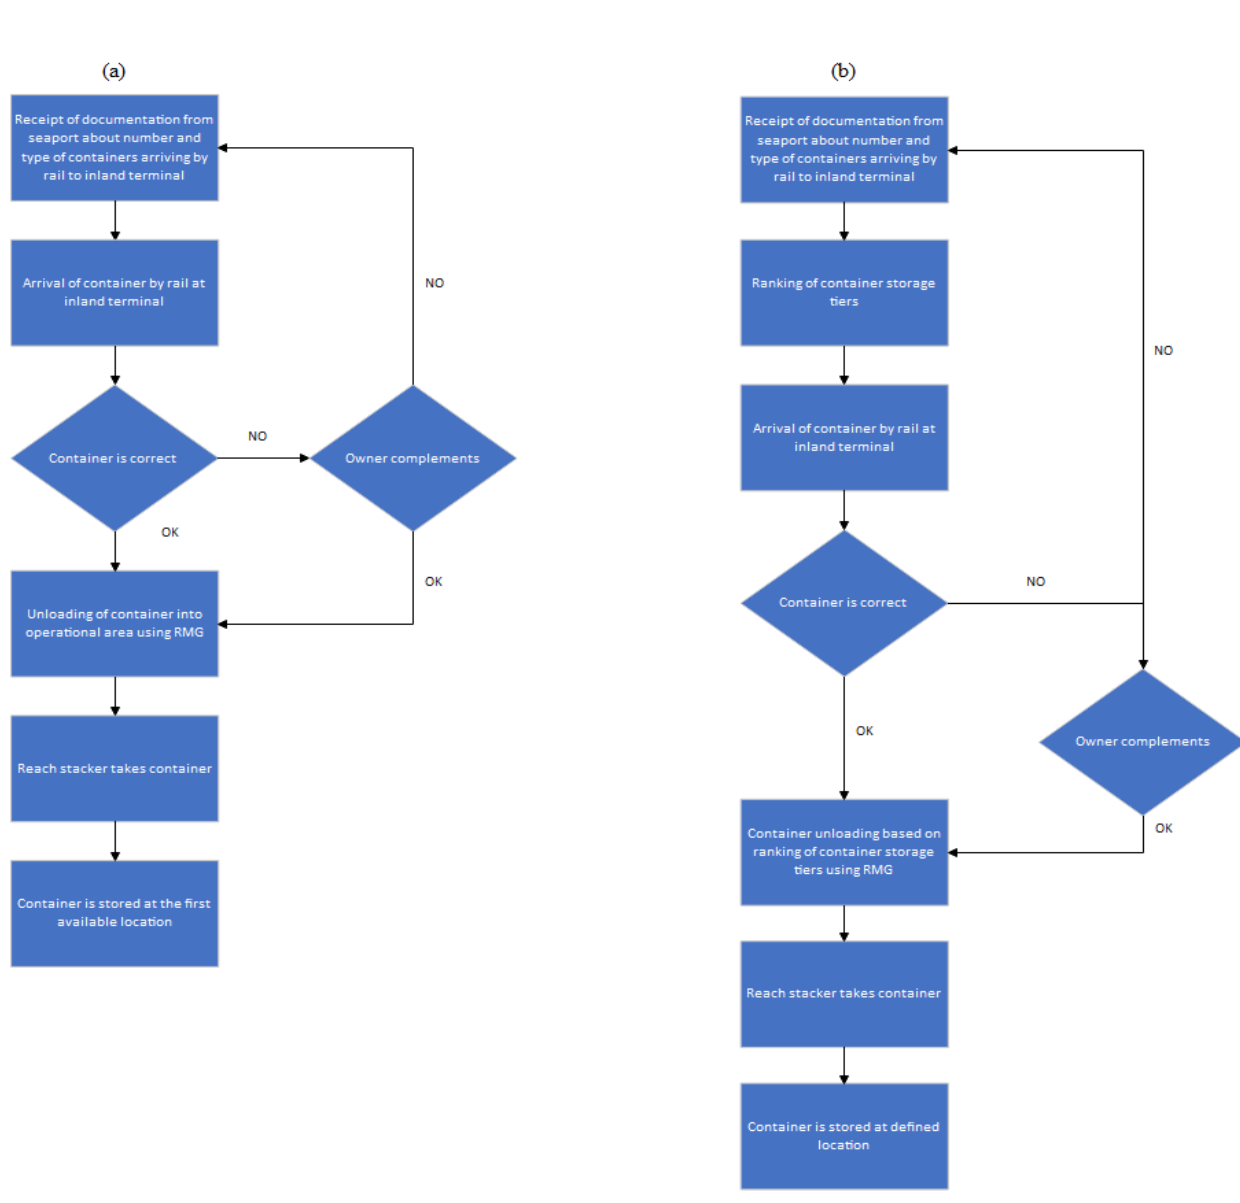
Figure 5. Container storage processes at the simulated inland terminal ( a ) as observed or ( b ) according to the proposed mathematical model.